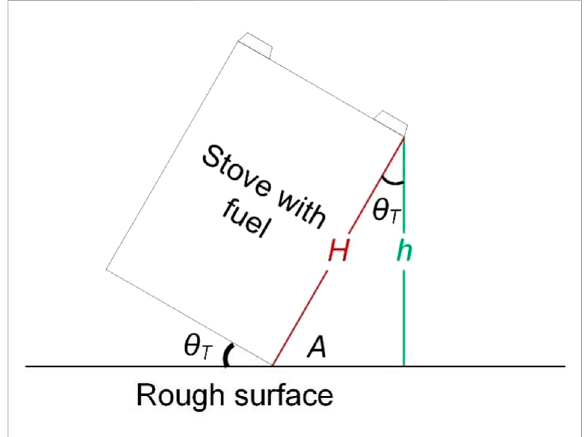
FIGURE 2 Geometry for the determination of the tipping angle for the stove safety test as speci fi ed in the BSSP standards. The tipping angle T is the angle at which the center of gravity would pass the rotation point